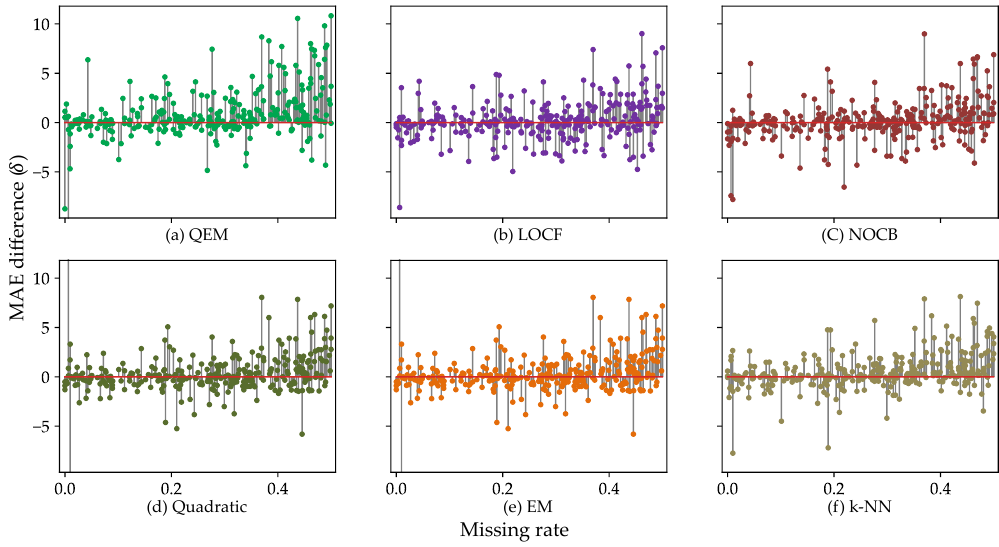
Figure 11. MAE differences between each model and